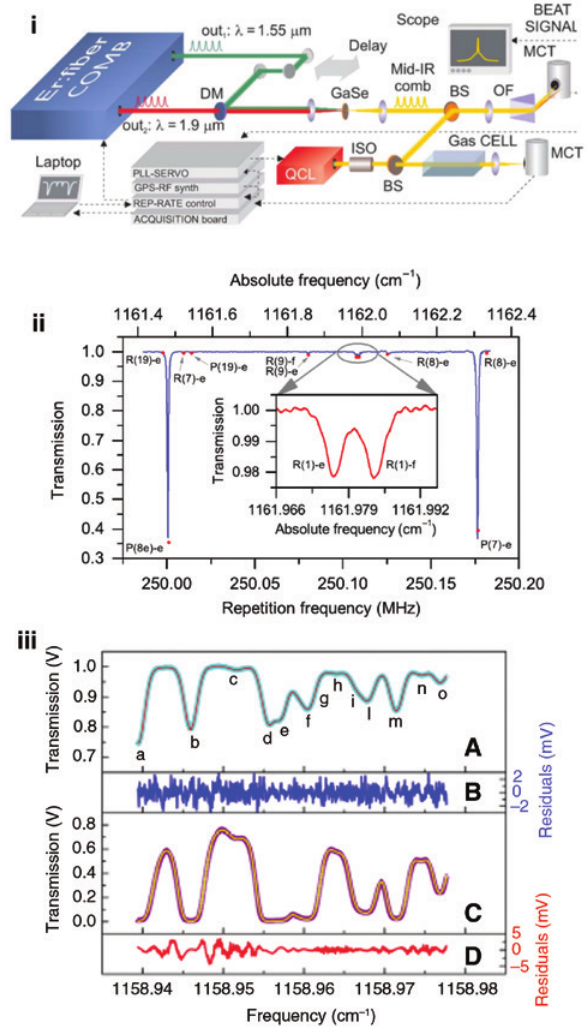
O spectroscopy Figure 10: (i) Experimental setup for absolute N 2 at 8.6 μ m. A mid-IR comb generated by a non-linear process in GaSe starting from the two output of a Near-IR comb is used as metrological reference for spectroscopy of N O e CH F in the region of 2 3 8.6 μ m. Reprinted with permission from [75], copyright 2015. (ii) N O 2 transmission spectrum at 8 mbar (800 Pa) pressure, resulting from a wide scan of the comb rep-rate (bottom scale) and corresponding QCL absolute frequency (top scale). Red dots: HITRAN calculated absorption-peaks in correspondence of our experimental conditions. Inset: detail of the R(1)-e-R(1)-f doublet with a 2% peak fractional absorption. Reprinted with permission from [75], copyright 2015. (iii) (A) CHF transmission profile around 8.6 μ m recorded at a 3 temperature of 296 K and a pressure of 8.8 Pa (green curve) together with a multi-line (13 line) Voigt fitting (red curve). (B) Fit residuals. (C) and (D) are the same as (A) and (B) but with a pressure of 200 Pa. Reprinted with permission from [74], copyright